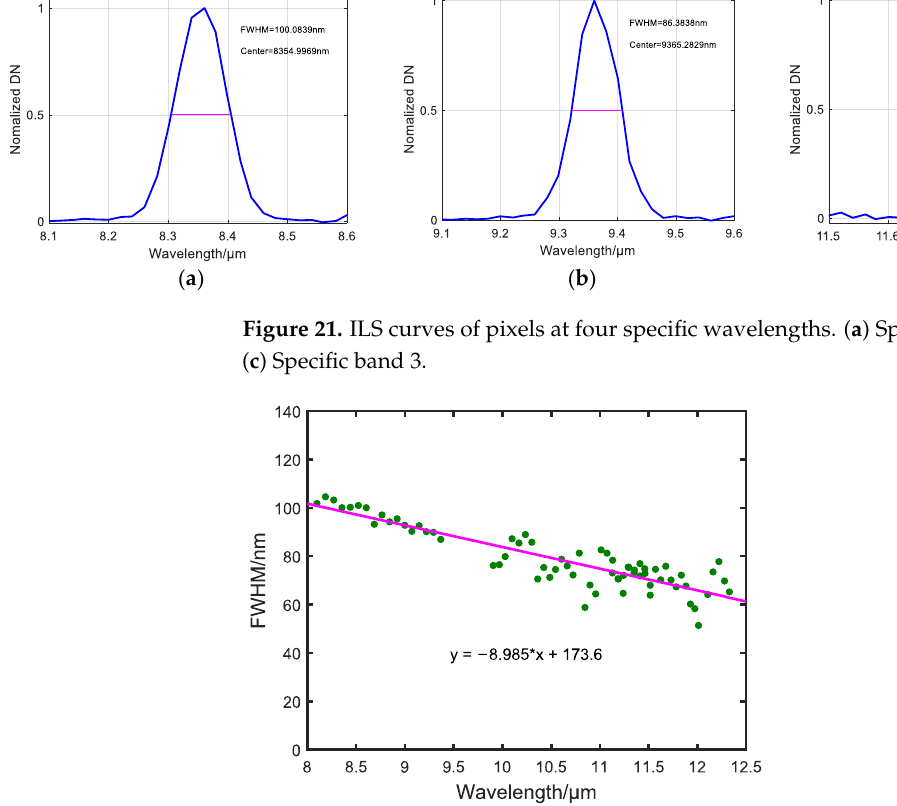
Figure 22. Measured spectral resolution in the full spectrum.